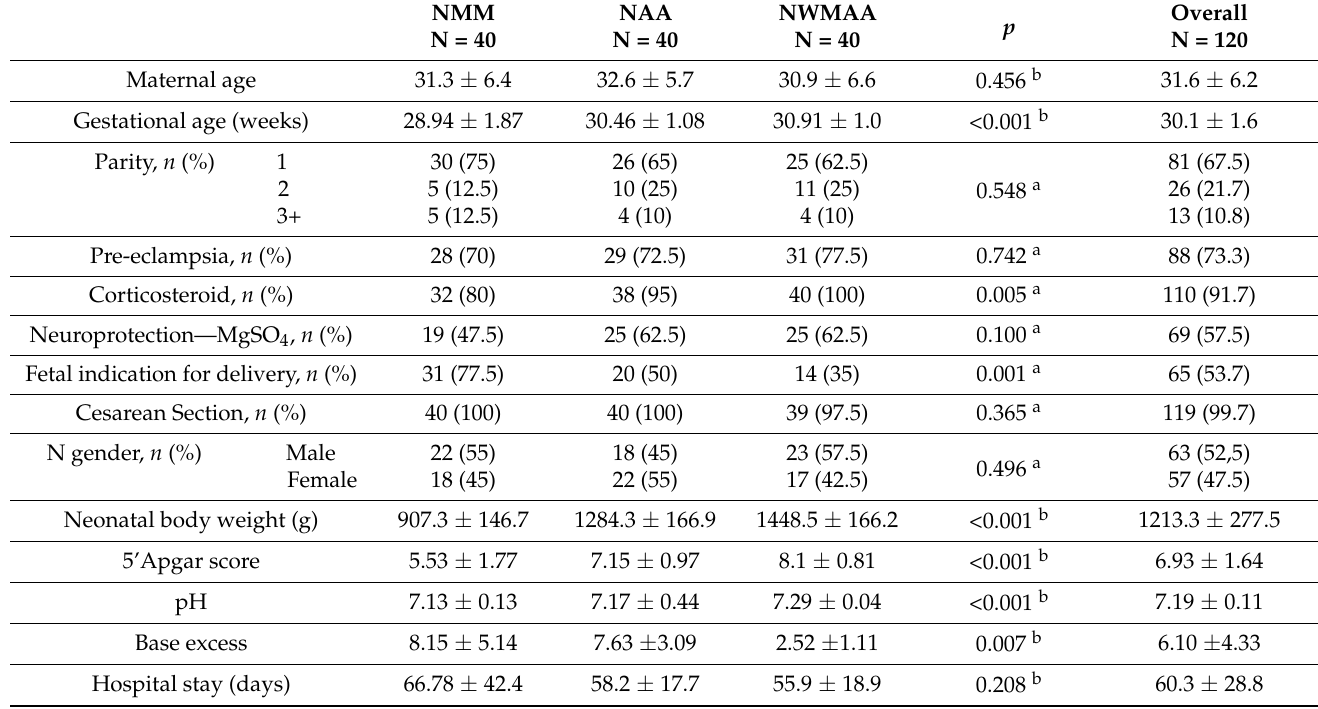
Table 1. Patient characteristics in early preterm growth-restricted neonates ( ≤ 32 wg).